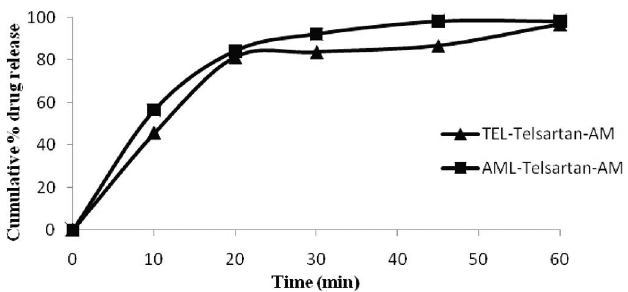
FIGURE 2 – In vitro dissolution profile of Telsartan-AM tablets in SGF media at 75 rpm (n =